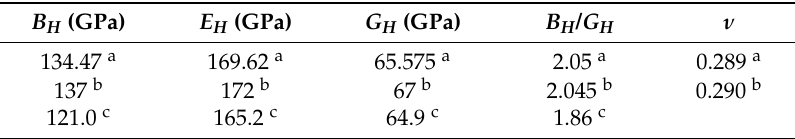
Table 5. Elastic moduli B , E and G , the B / G ratio, and the Poisson’s ratio, ν , in the Hill approximation, at 0 GPa.